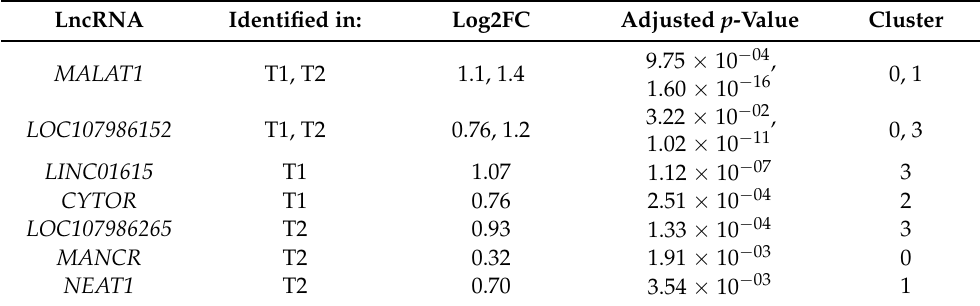
Table 2. Significant upregulated